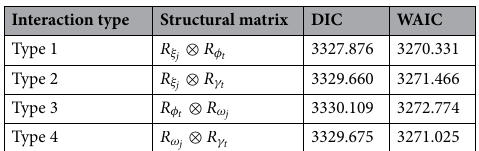
Table 6. By comparing the values of DIC and WAIC in Table 6, type 3 is selected as the Spatio-temporal interac- tion type on level 2 of the model (1). Data availability